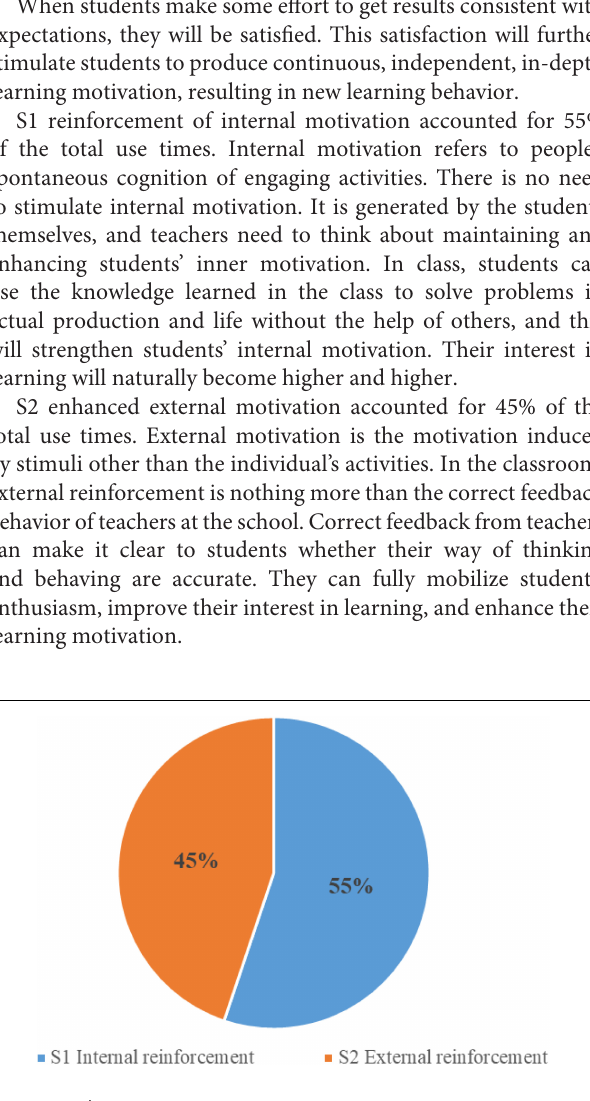
FIGURE 4 | Percentage of secondary strategy usage in satisfaction